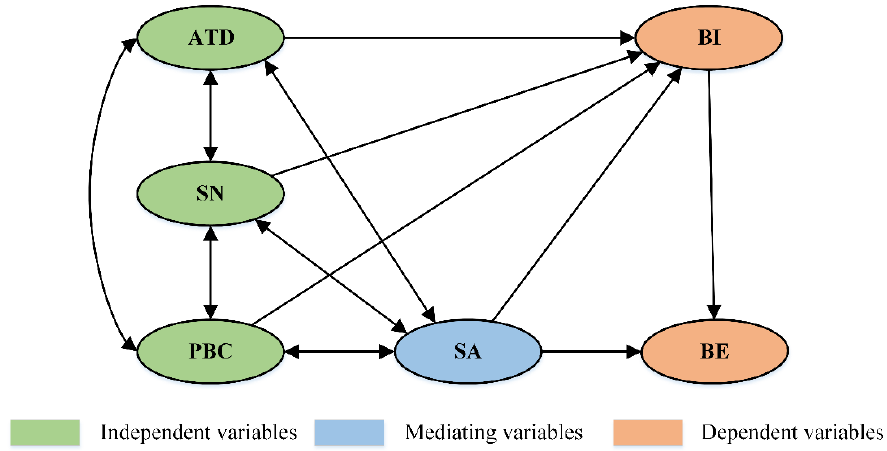
Figure 5. Path of the hypothetical structural equation model.